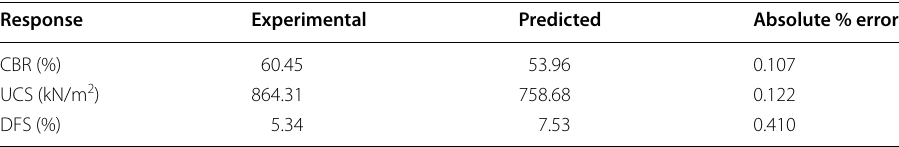
Table 13 Comparison of experimental and predicted values of the responses obtained from VRS- DEA Taguchi